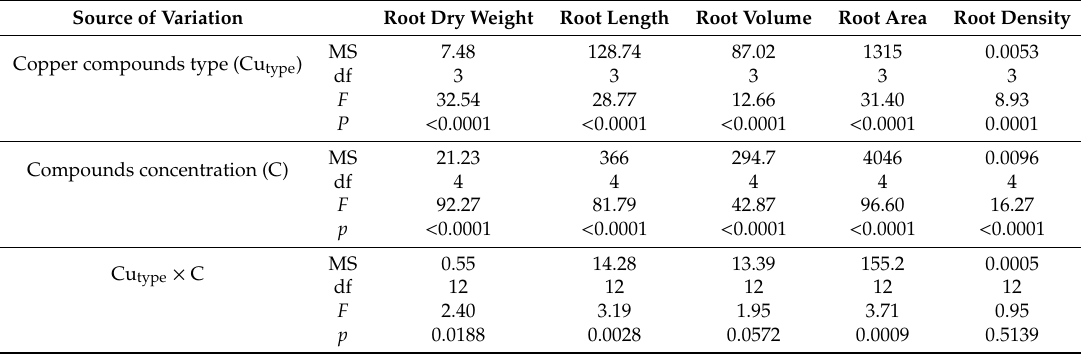
Table 2. Statistical analysis (ANOVA) of root morphological parameters for soybean grown in soil amended with di ff erent copper (Cu) compound types and concentrations.